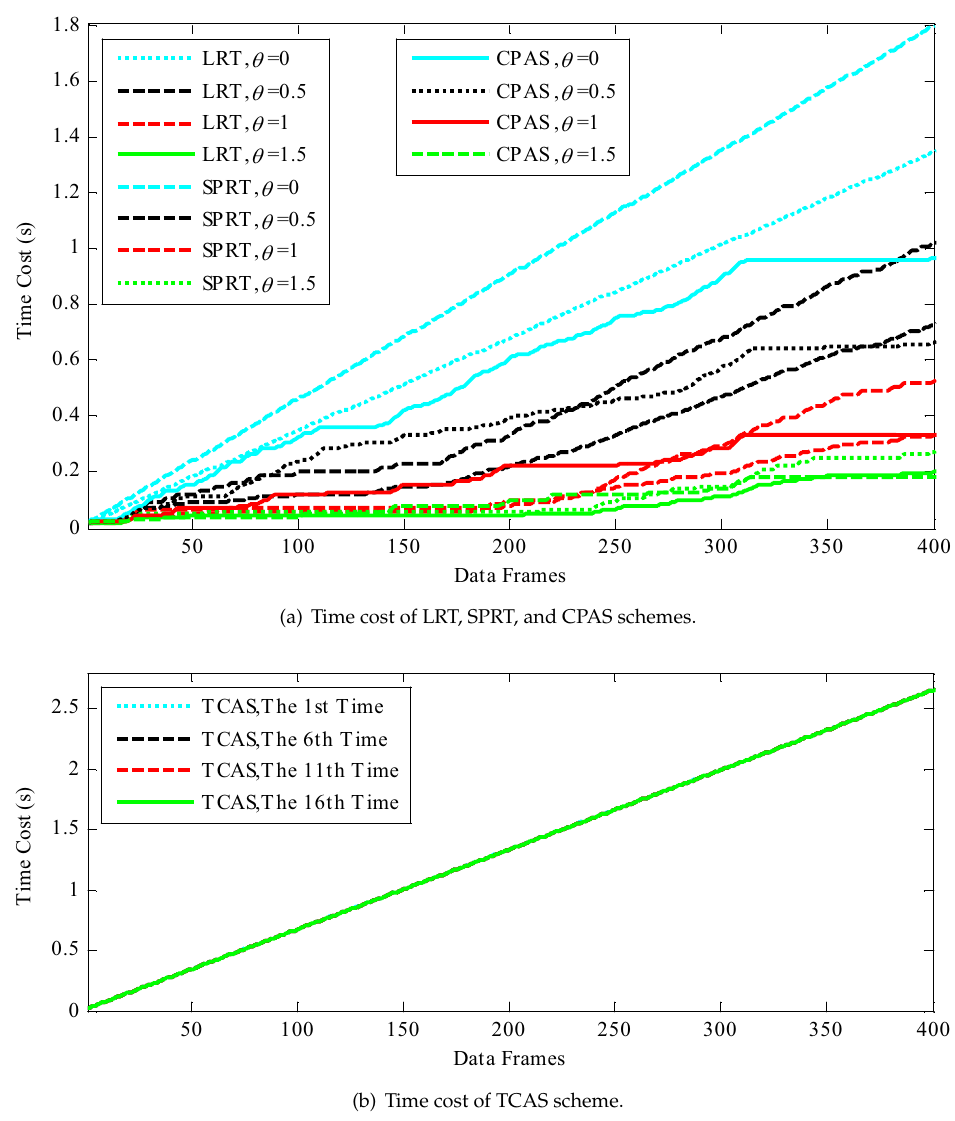
Figure 16. Time cost of data frames authentication, where the time cost included the physical layer channel authentication time cost (if any), upper layer cipher authentication time cost, and data demodulation time cost: ( a ) the time cost of LRT, SPRT, and CPAS schemes under different threshold values; and ( b ) the time cost of the TCAS